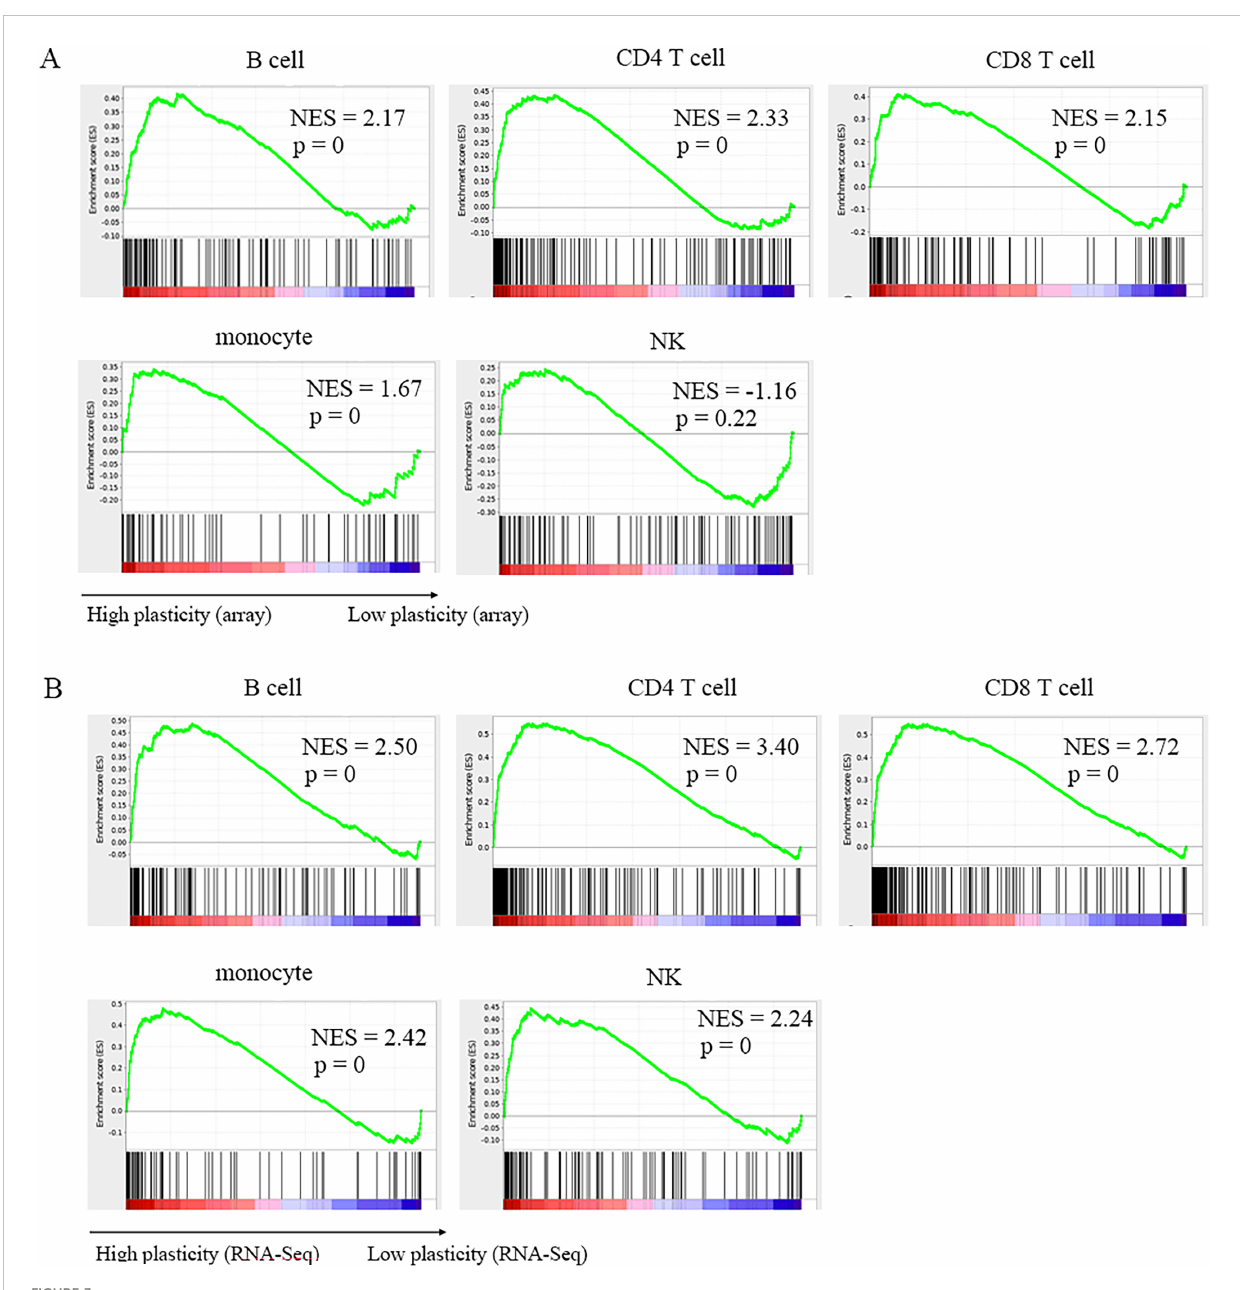
FIGURE 3 Functional enrichment analysis of marker gene sets based on gene plasticity measured by absolute GPL score. (A, B) represent results from microarray (A) or RNA-Seq (B) data in the indicated cell